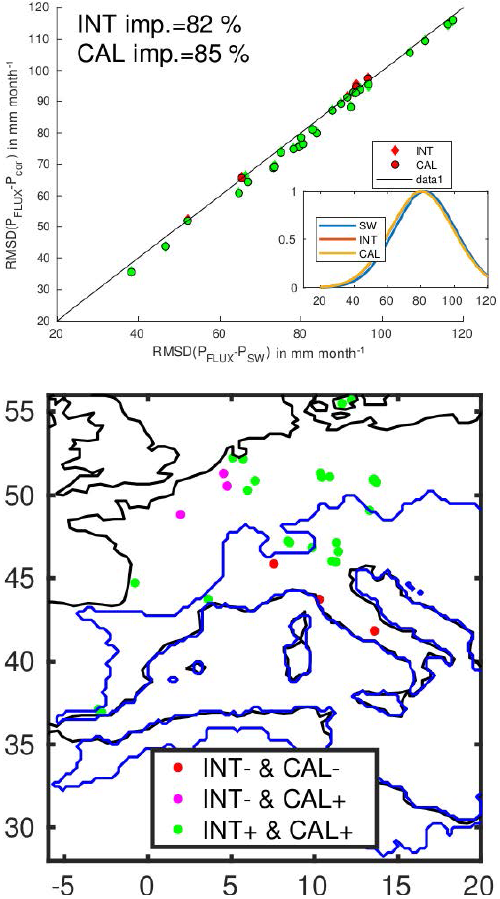
Figure 5. Same as Fig. 4 but for